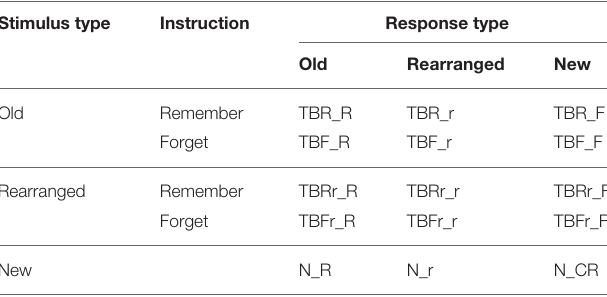
TABLE 1 | Abbreviations for each